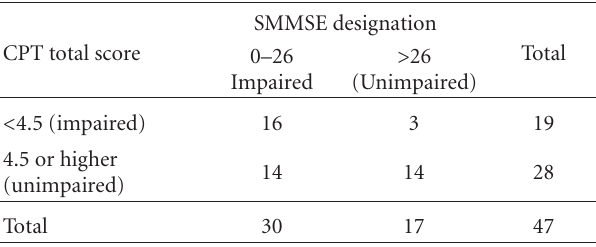
Table 3: Designation of functional impairment: Phi test of CPT and SMMSE.